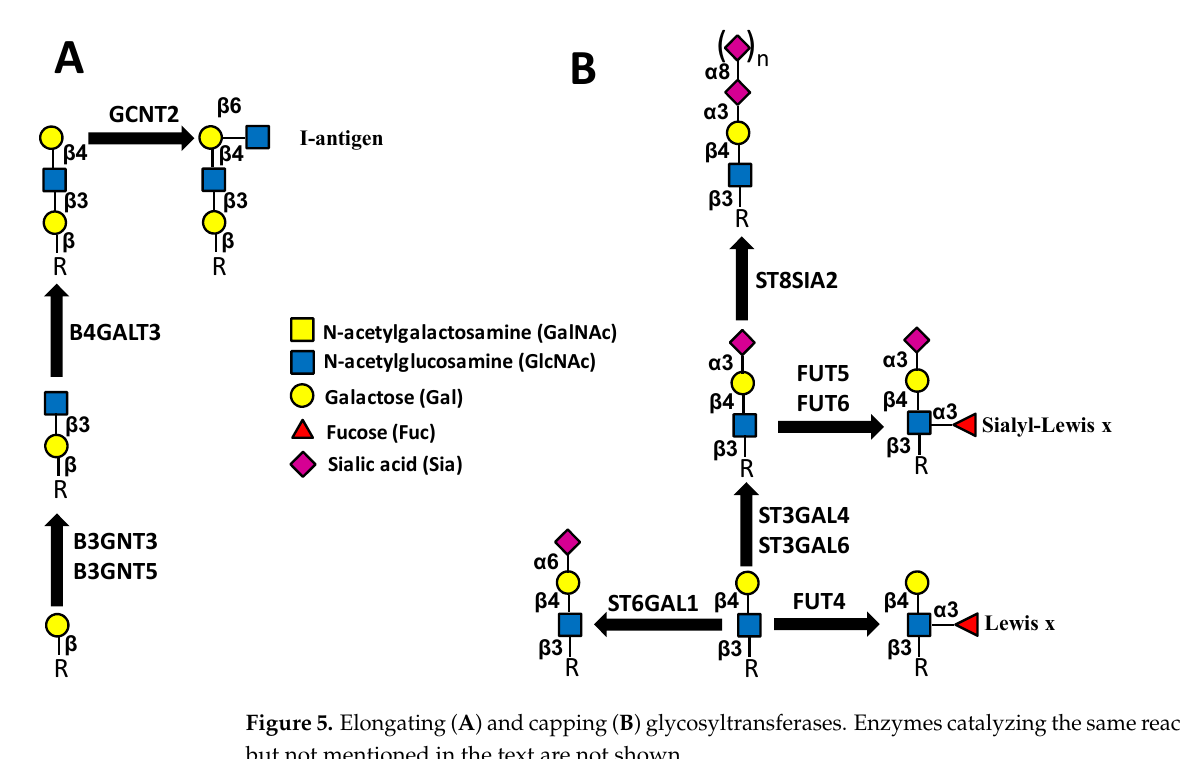
Figure 5. Elongating ( A ) and capping ( B ) glycosyltransferases. Enzymes catalyzing the same reactions but not mentioned in the text are not